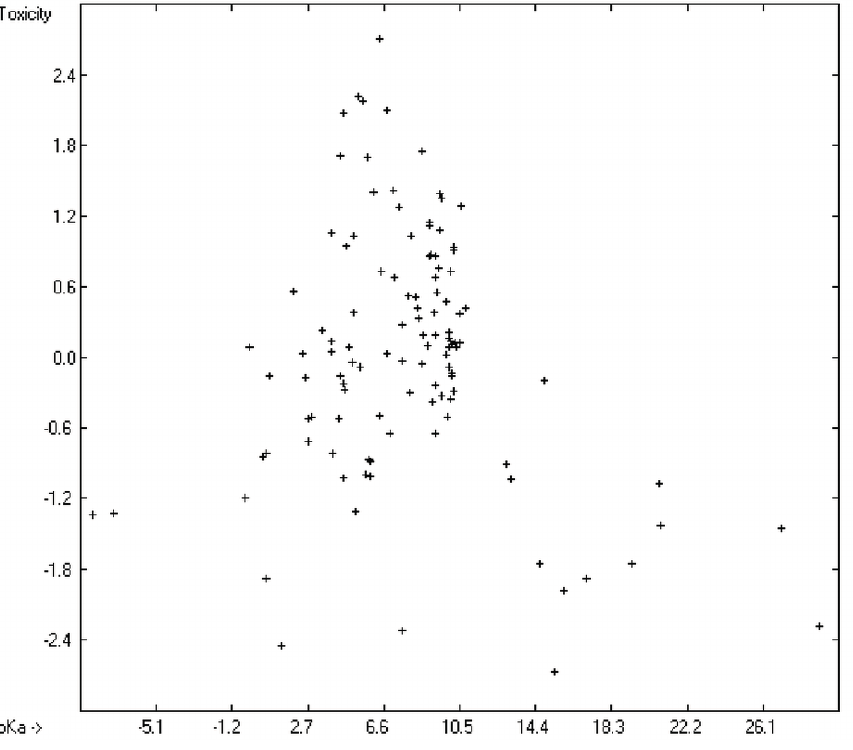
Figure 16. Correlation diagram of pKa against toxicity (N = 112, R 2 =